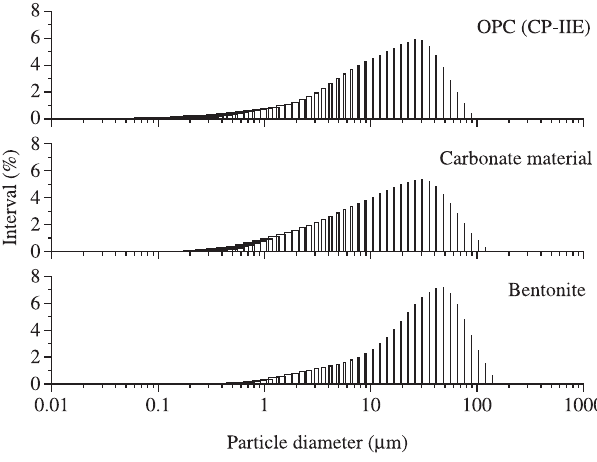
Figure 1. Particle size distribution of OPC (CP-IIE), carbonate material and